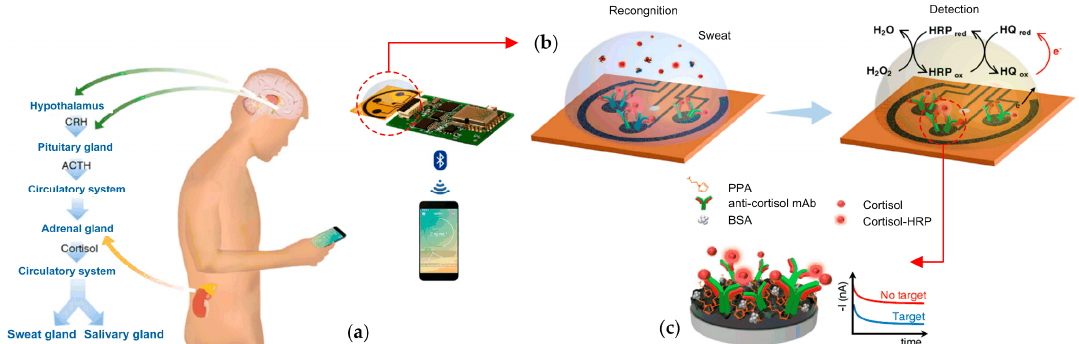
Figure 8. Integrated wireless graphene-based sweat stress sensing platform. ( a ) Schematic illustration of the origin of cortisol in sweat and saliva and the use of the GS4 to track the circulating cortisol level. CRH, corticotropin-releasing hormone; ACTH, adrenocorticotropic hormone; ( b ) schematic of the electrochemical detection of cortisol in human sweat; and ( c ) representation of the affinity-based electrochemical cortisol sensor construction and sensing strategy. HRP, horseradish peroxidase; HQ, hydroquinone; PPA, pyrrole propionic acid; BSA, bovine serum albumin; mAb, monoclonal antibody (reprinted with permission from [75]).